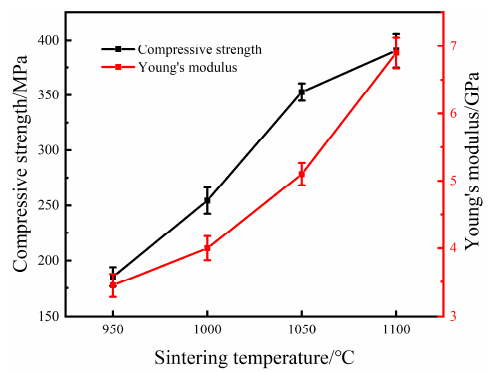
Figure 7. The relation of the compressive strength and elastic modulus of the specimen with its sintering temperature.